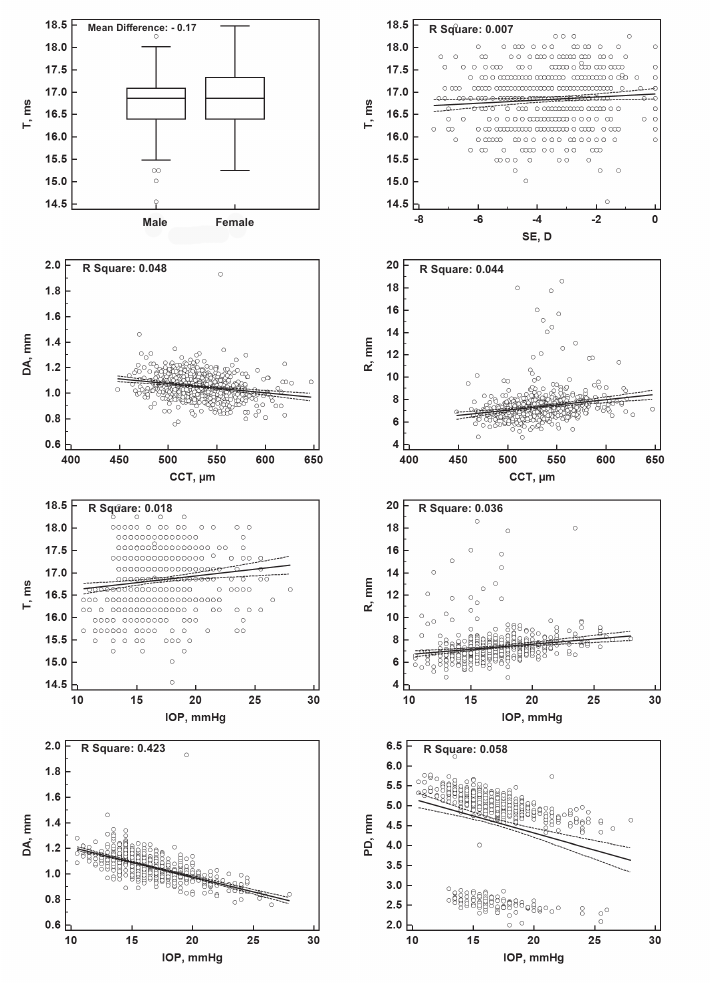
Figure 3. Significant determinants of the selected Corvis ST parameters at the highest concavity moment. CCT, central corneal thickness; IOP, intraocular pressure; SE, spherical equivalent